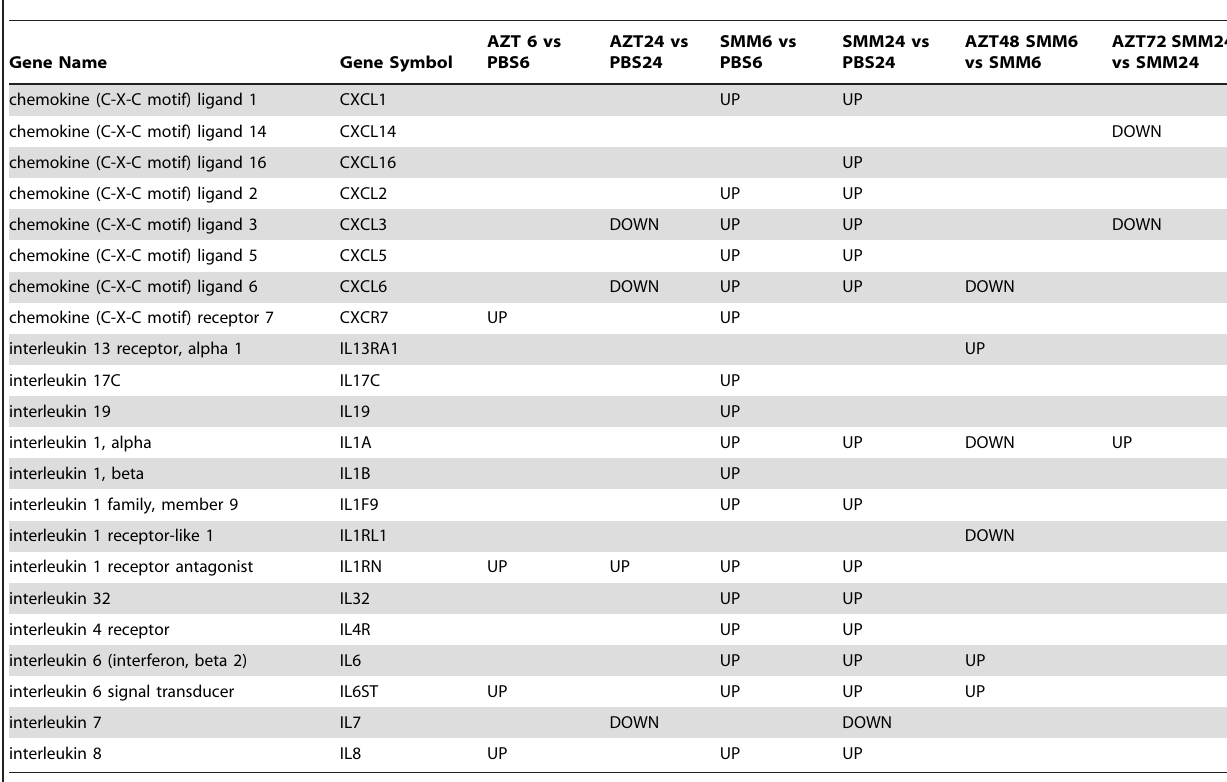
Table 5. Response of cytokine/chemokine genes and their receptors for the selected treatment